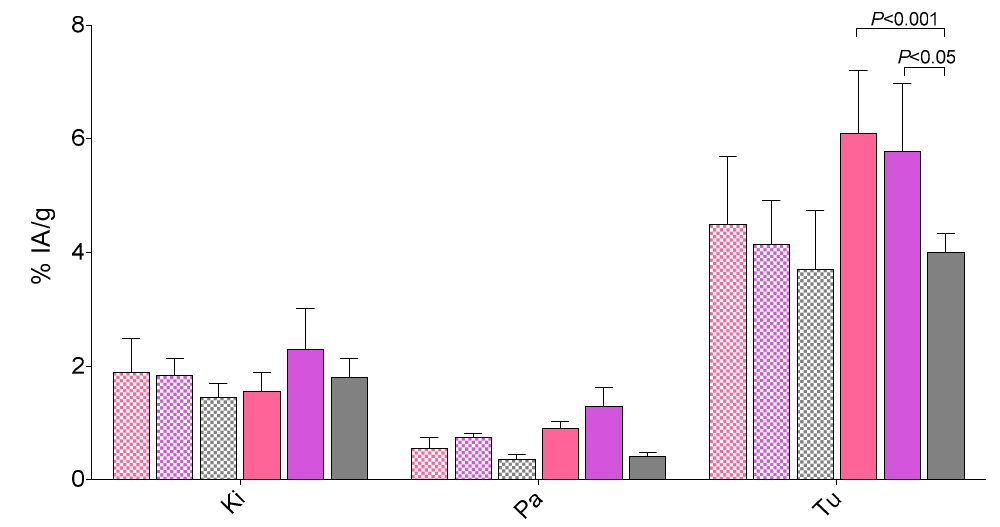
Figure 5. Selected biodistribution data for [ 99m Tc]Tc-DB7 (pink bars), [ 99m Tc]Tc-DB13 (violet bars), and [ 99m Tc]Tc-DB14 (gray bars) for kidneys (Ki), pancreas (Pa), and PC-3 tumors (Tu) at 4 h pi in female SCID mice bearing subcutaneous PC-3 xenografts; results are expressed as %IA/g mean ± SD, n = 4, without (checkered bars) or with coinjection (solid bars) of PA. Only statistical differences in organ/tumor uptake across compounds are included in the diagram; statistical differences between PA- treated and nontreated mice are shown in Tables 1, 2, and 3.